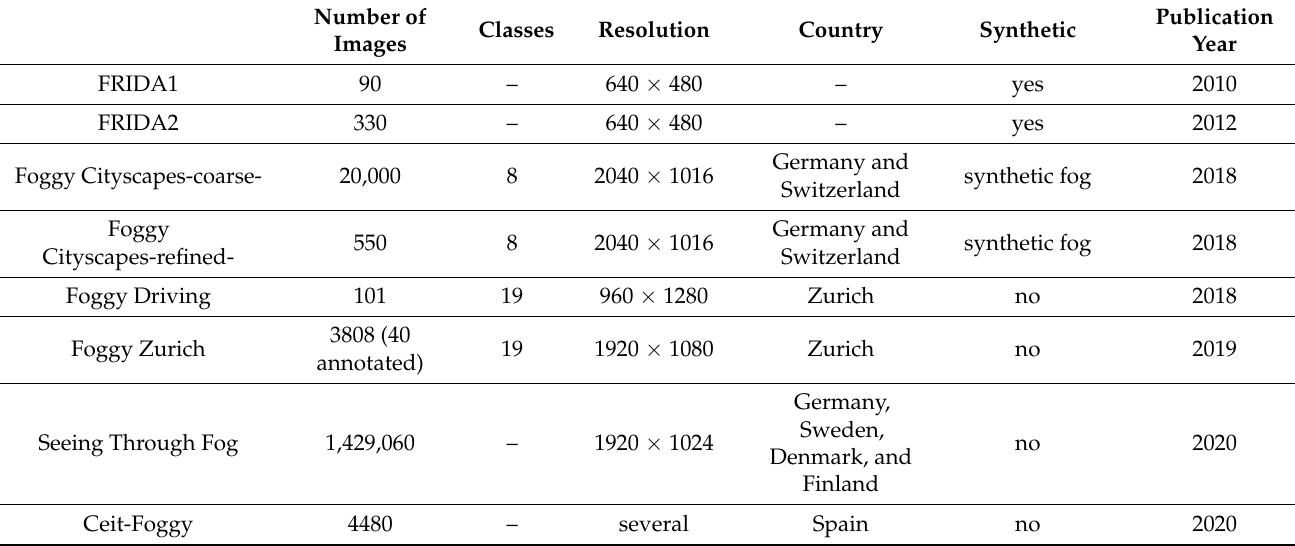
Table 2. Summary of the existing datasets for fog detection and its principal